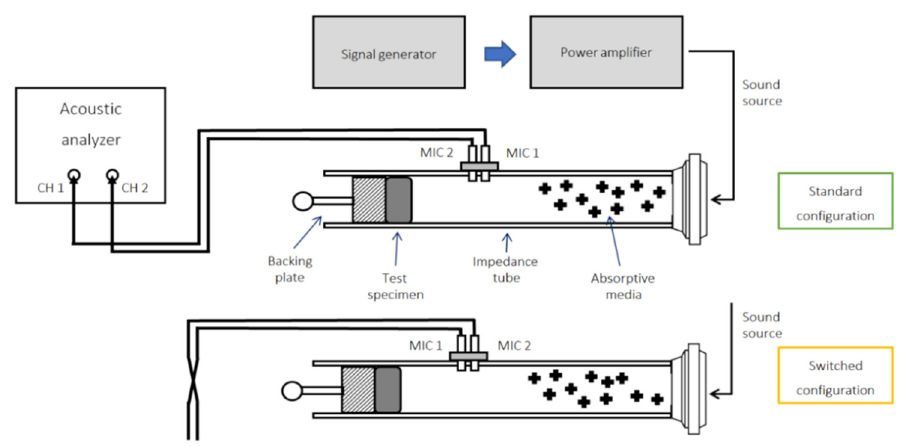
Figure 1. Schematic of the instrumentation used in this study to measure the sound absorption coefficient.